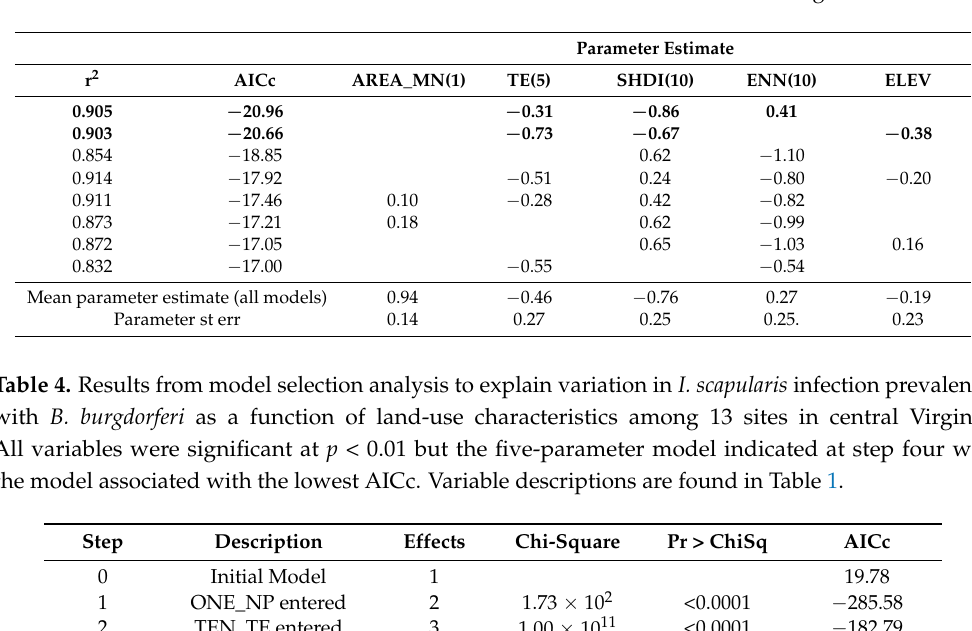
Table 3. Parameter estimates and AICc scores for the top eight (models with ∆ AICc ≤ 2 in bold) models used to predict average I. scapularis density among 13 sites in Virginia. This suite of variables had a maximum condition index of 6.5 and no variables had a variance inflation factor higher than 6.5.